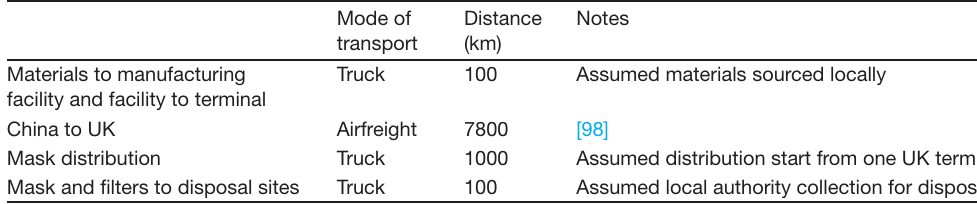
Table A7. Transport assumptions for masks and filters for all scenarios.